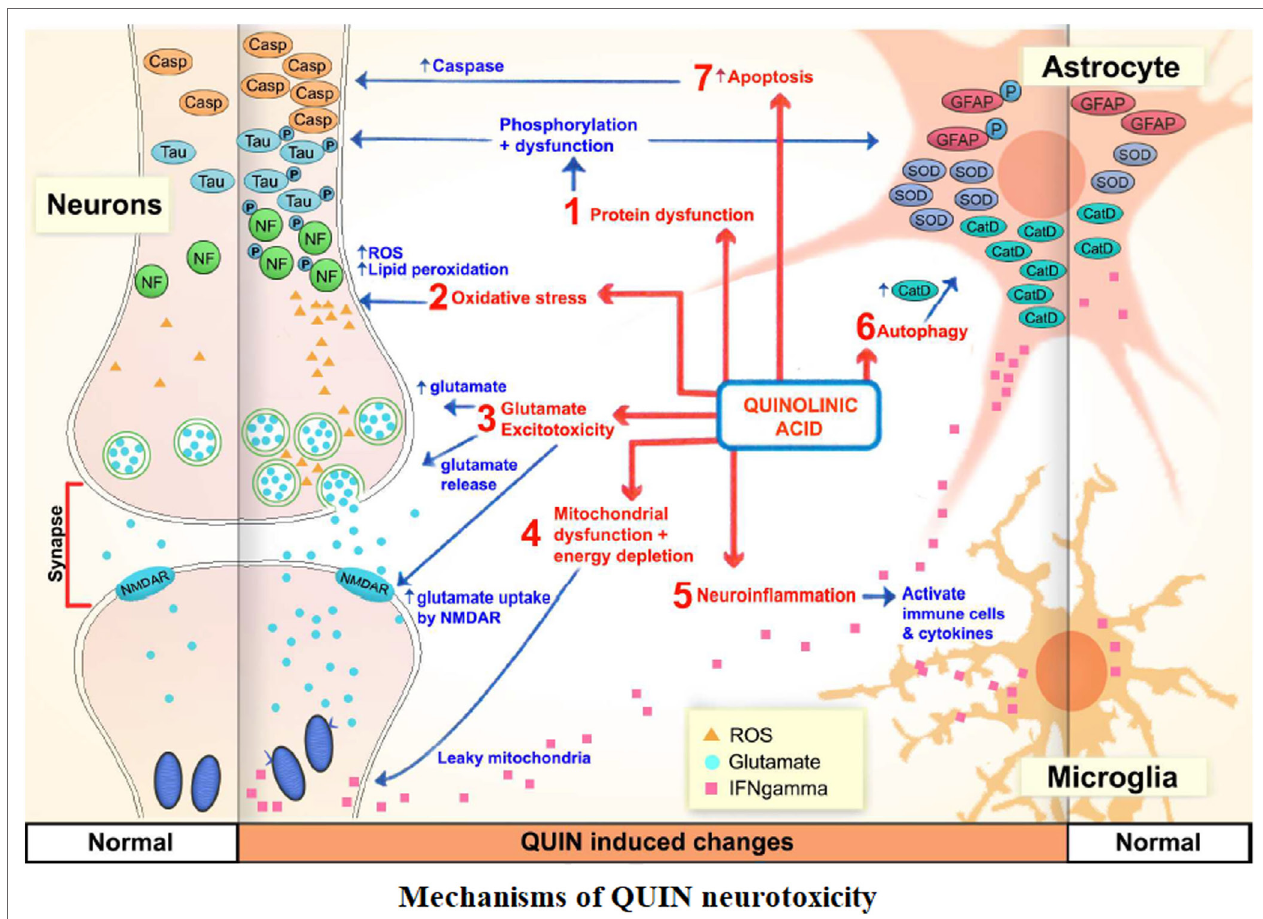
FigURe 2 | The mechanisms of QUIN neurotoxicity. Increased QUIN expression levels could increase blood–brain barrier permeability, initiate and/or exacerbate a myriad of neurotoxic processes, such as mitochondrial dysfunction, excitotoxicity, oxidative stress, protein phosphorylation, and autophagic